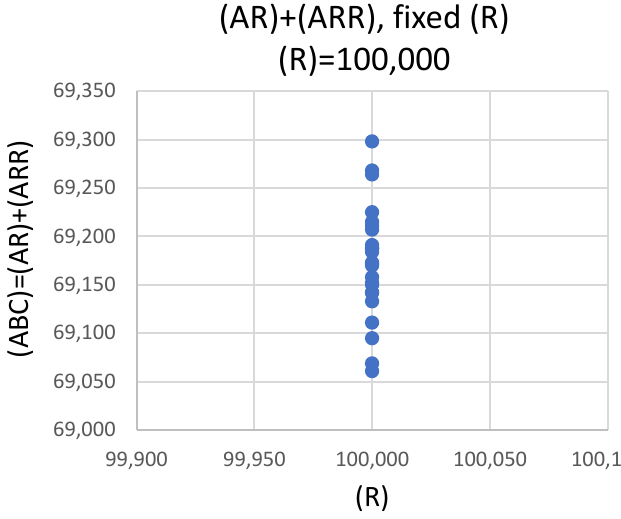
Figure 5. Equilibrium values of (AR) + (ARR) at the end of 25 calculations of the stochastic model. The values (AR) and (ARR) are correlated to yield a very small CV% for (ARR) + (AR). The CV% for (AR) and CV% for (ARR), taken individually, are much larger.